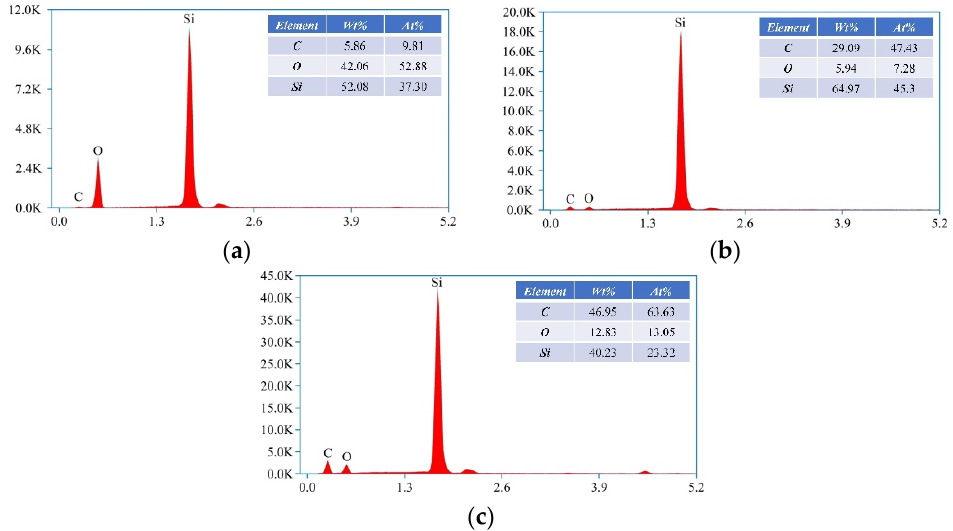
Figure 6. EDS spectra of different processed surfaces: ( a ) white products, ( b ) normal processing surface at point B, ( c ) deposit surface at point C.